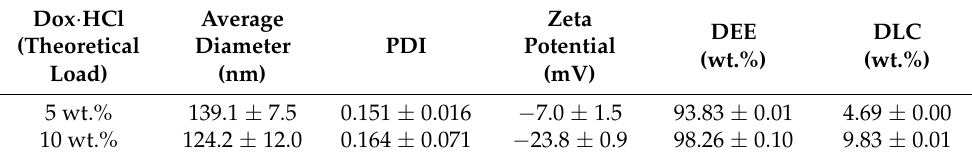
Table 1. Physicochemical characteristics of the drug-loaded polymersomes.